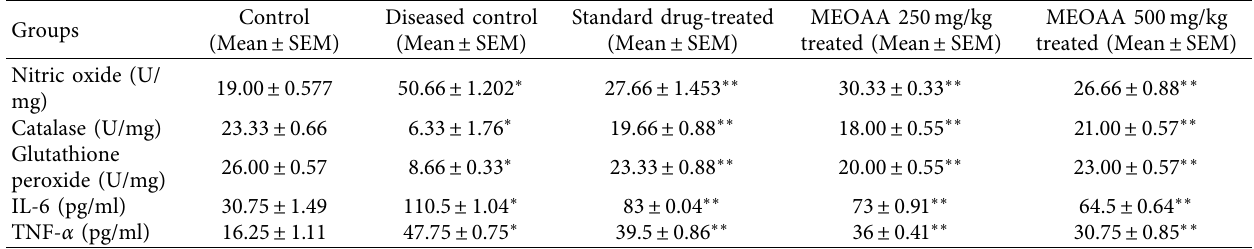
Table 3: Effect of A. arvensis on nitric oxide, catalase enzyme and glutathione peroxide.